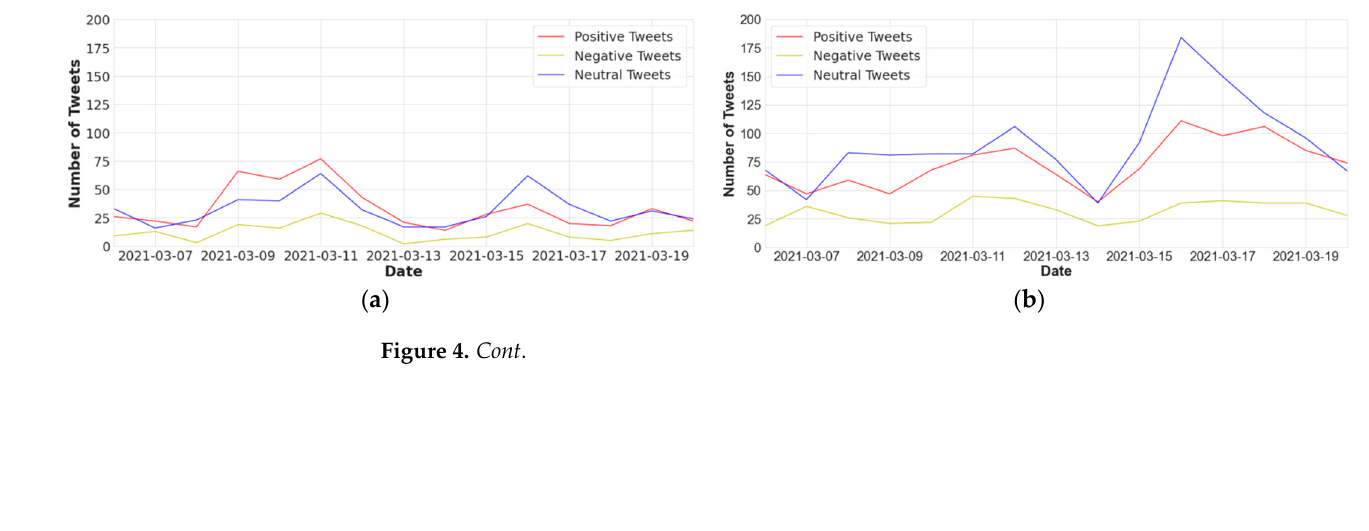
Figure 3. Different COVID-19 vaccines’ sentiment distribution over time and rolling mean: ( a ) Co- vaxin sentiment distribution over time and rolling mean; ( b ) Moderna sentiment distribution over time and rolling mean; ( c ) Pfizer sentiment distribution over time and rolling mean; ( d ) Sinopharm sentiment distribution over time and rolling mean.